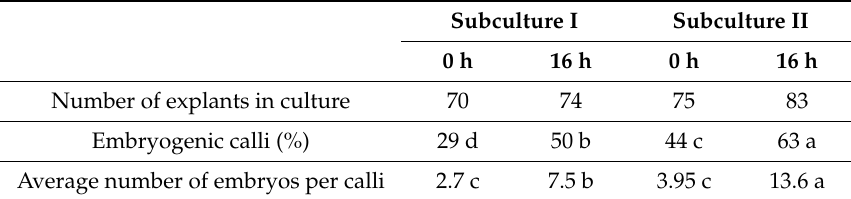
Table 3. Percentage of embryogenic calli and the average number of somatic embryos achieved in radicles inoculated on ECO medium during two subcultures, 30 days each, and under two light regimes, 16 h and 0 h photoperiod. Di ff erent letters correspond to statistically significant di ff erences ( p ≤